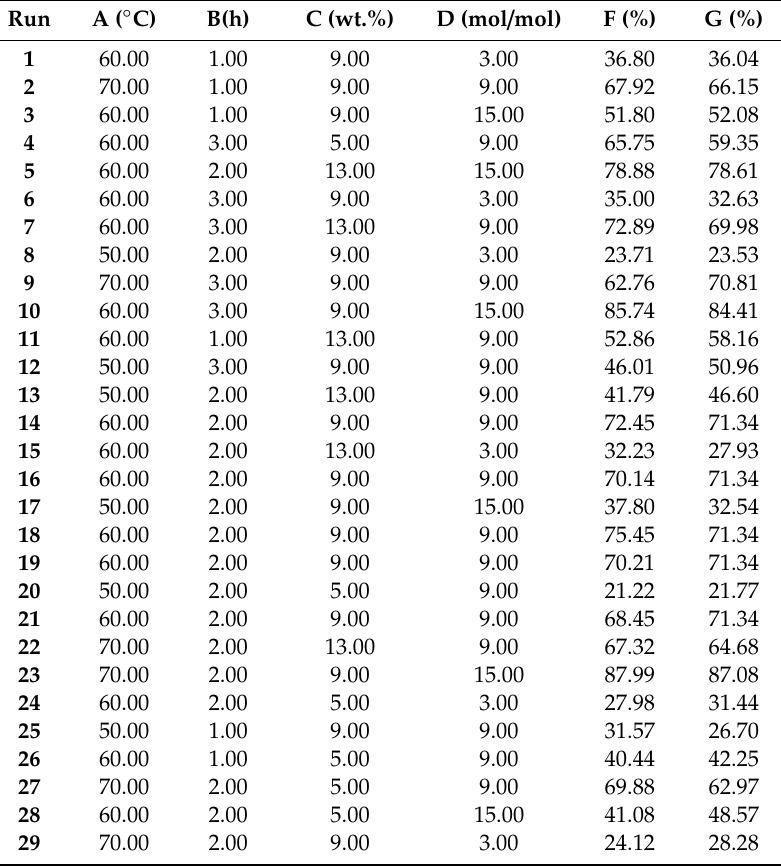
Table 3. Design and results of the response surface